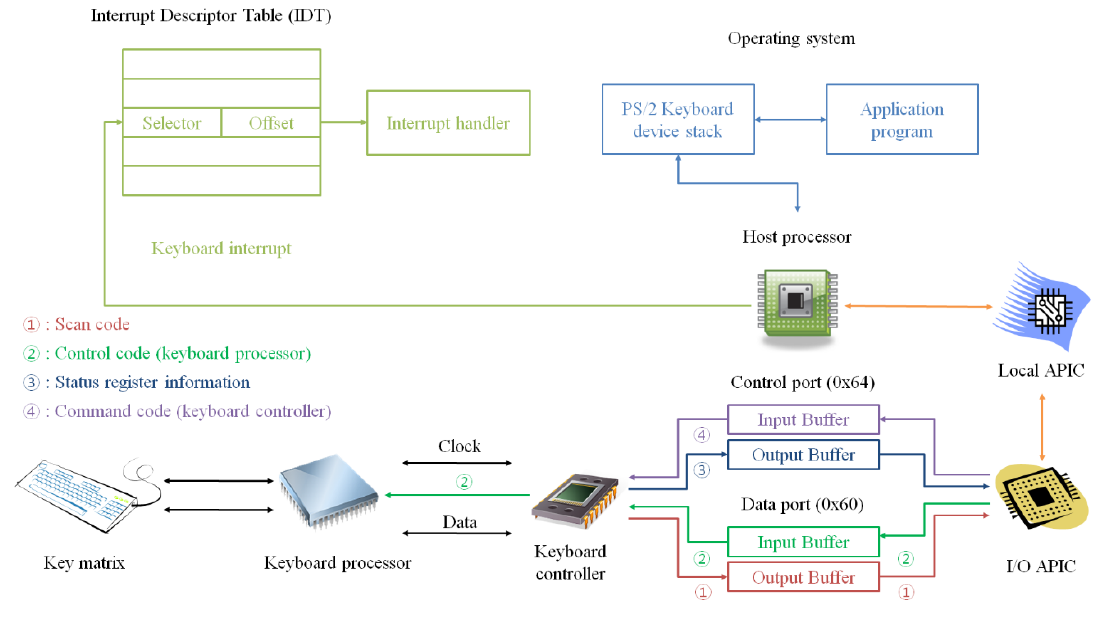
Figure 1. The keyboard data transmission process.